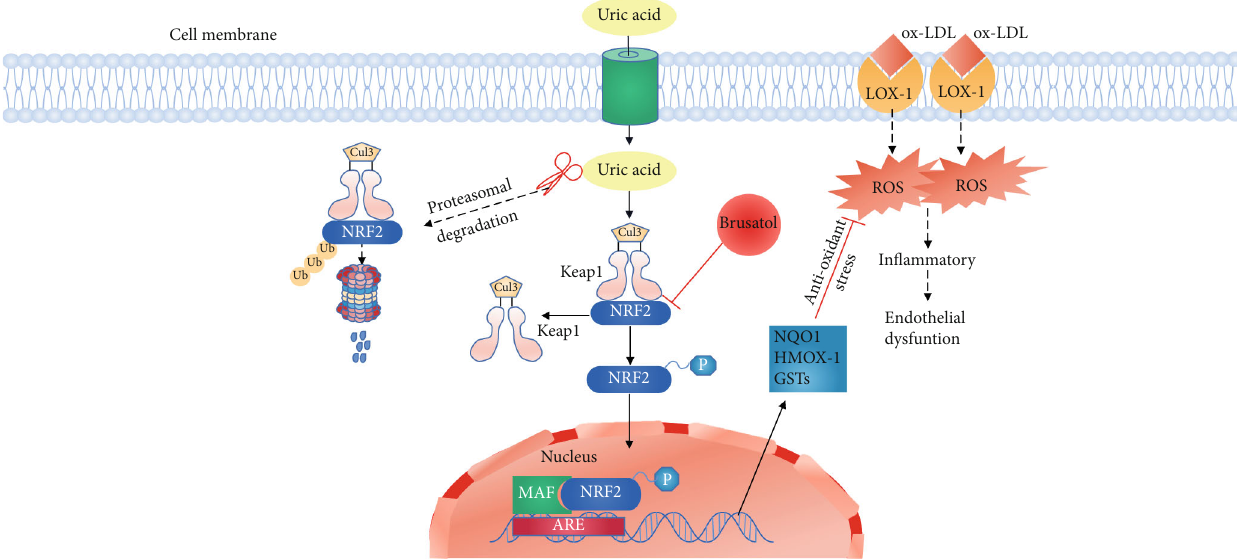
Figure 7: The potential protective mechanisms of UA on ox-LDL-induced HUVEC injury via the Keap1-Nrf2-Are